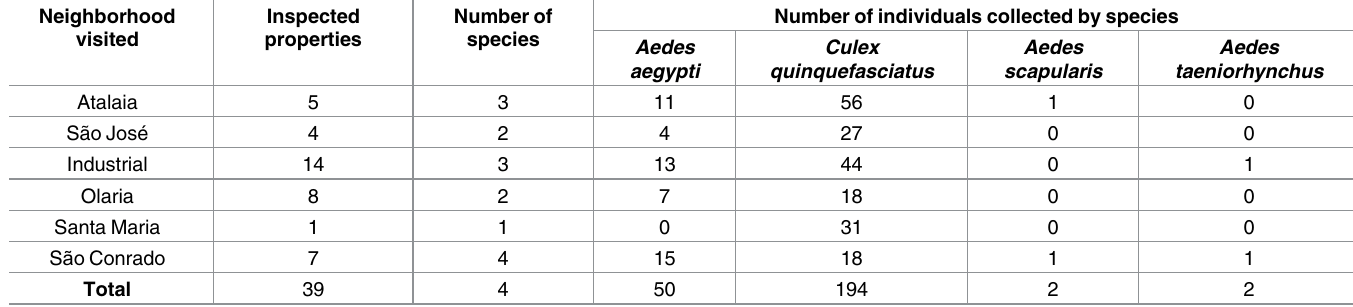
Table 1. Neighborhoods, inspected properties and mosquito species identified in Aracaju city, Sergipe state. Neighborhood visited